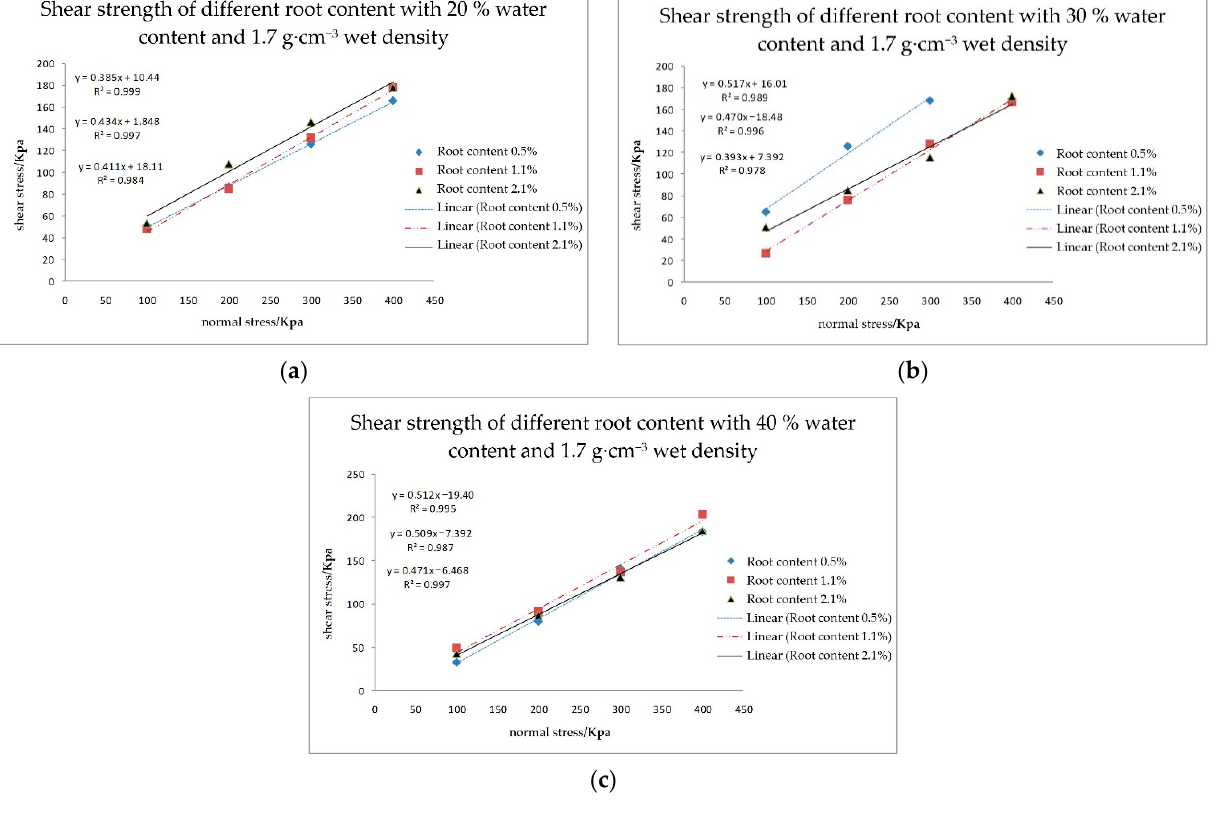
Figure 5. For each sample with 20%, 30%, and 40% water content τ s − σ s scatter plot and fitting line. Note: ( a ) 20% water content, 1.7g·cm − 3 wet density. ( b ) 30% water content, 1.7g·cm − 3 wet density. Note: ( a ) 20% water content, 1.7g · cm − 3 wet density. ( b ) 30% water content, 1.7g · cm − 3 wet density. ( c ) 40% water content, 1.7g·cm − 3 wet density. ( c ) 40% water content, 1.7g · cm − 3 wet